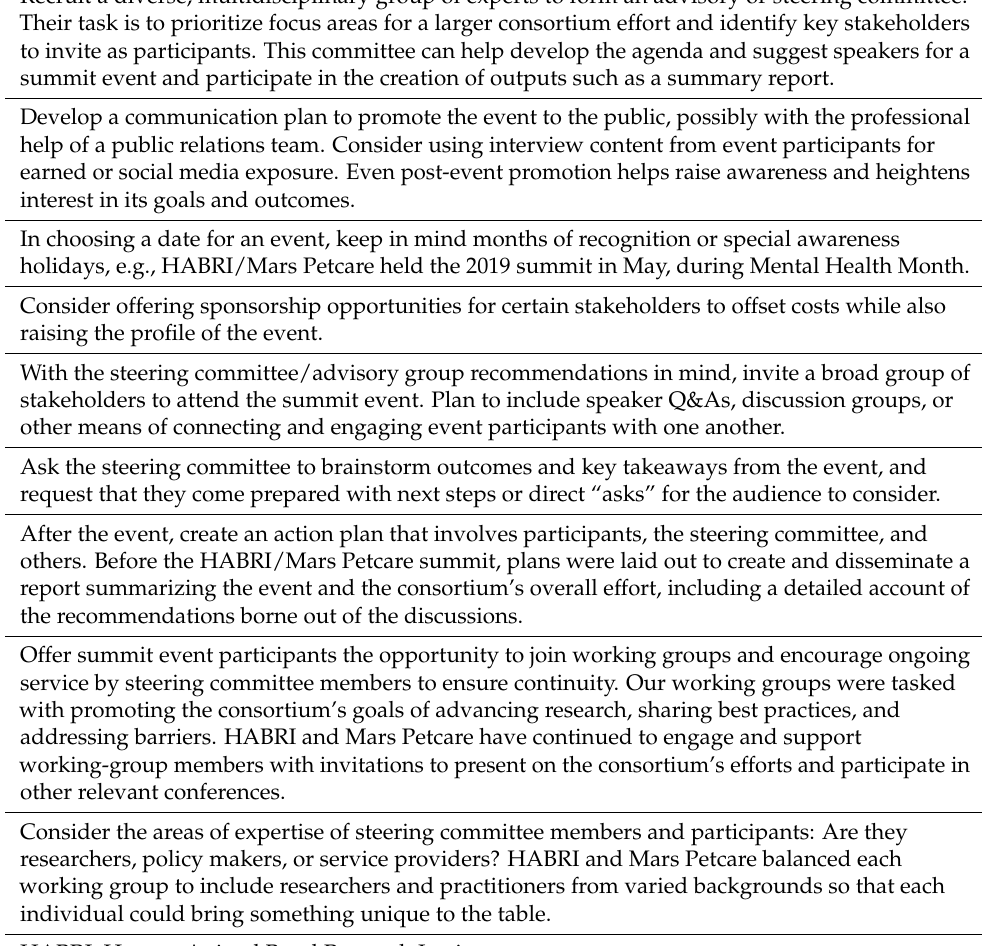
Table 3. Critical factors for the planning and execution of effective leadership initiatives based on the success of the Summit on Social Isolation and Companion